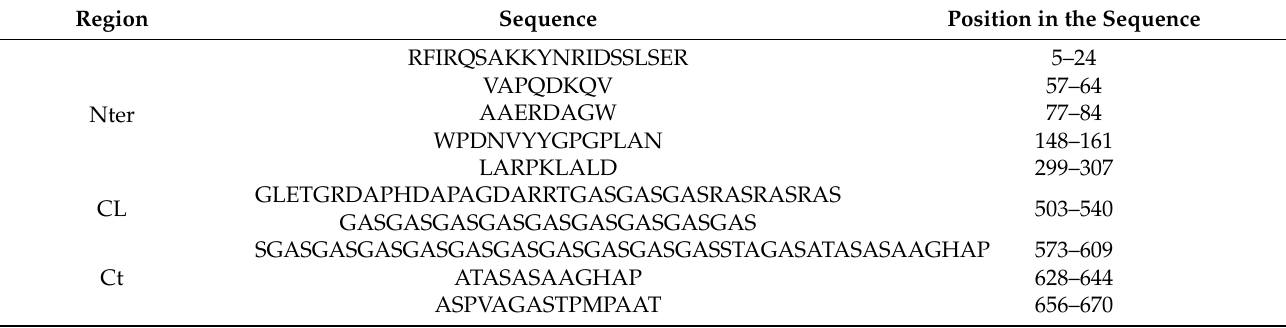
Table 2. Sequence based predicted B cell epitopes of Bucl8, computed using BepiPred.